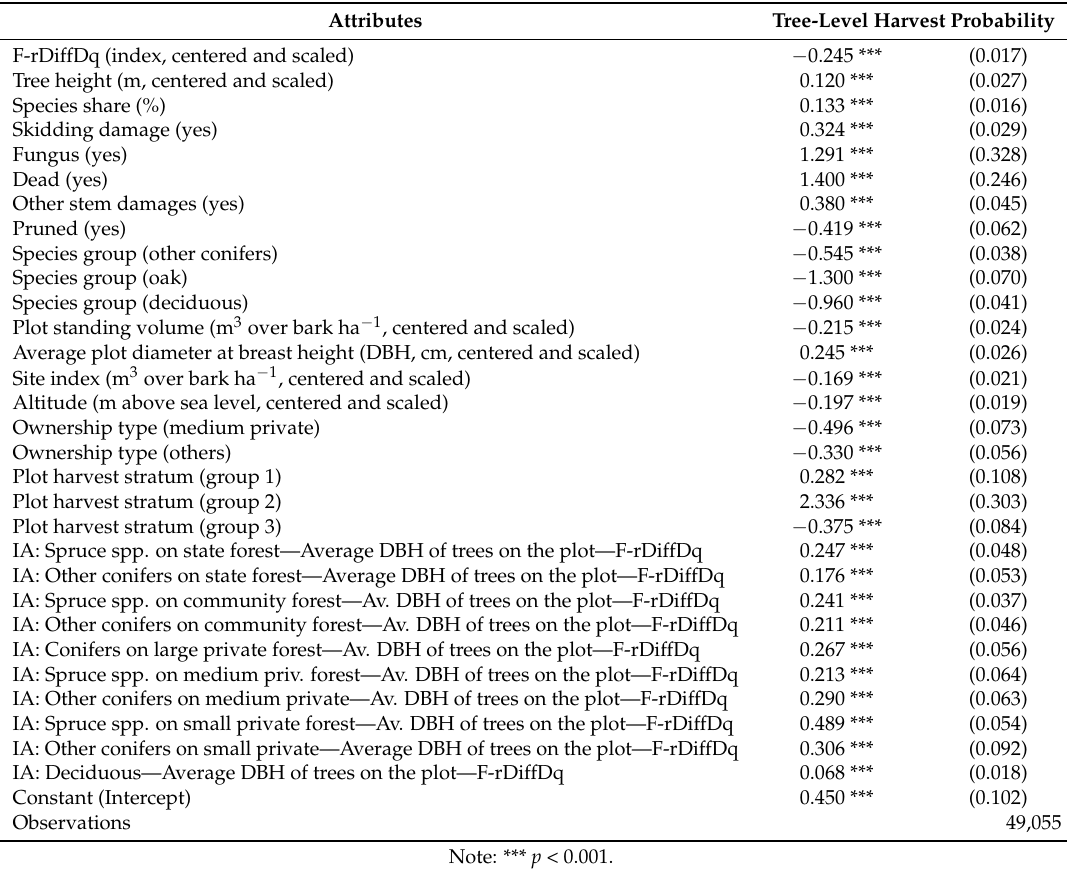
Table 1. Estimates, significance codes, and standard errors (in parentheses) for the generalized linear mixed model (GLMM) used to predict tree-level harvest probabilities. The model was fitted on sample trees from the training set inventory plots on which harvests occurred (49,055 sample trees on 5684 plots; IA: interaction).